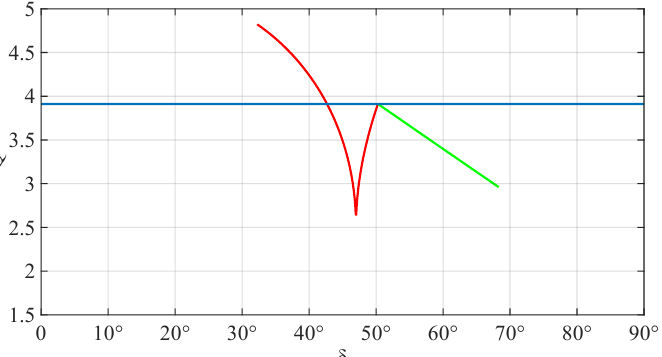
Figure 15. Drive force under transformable state C 1 and C 2 Q (10 mm) (Blue: wheel state; Red: C 1 ; Green: C 2 ).